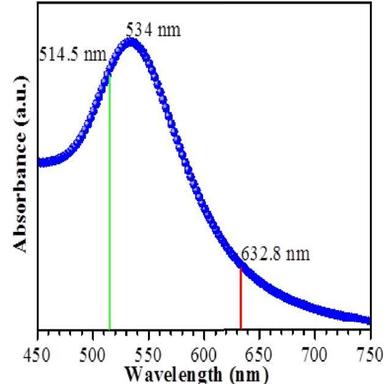
Optical absorbance of SERS substrate showing the importance of excitation laser for SERS efficiency.